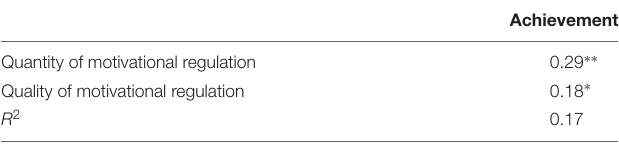
TABLE 3 | Regression of achievement (exam grade) on quantity and quality of motivational